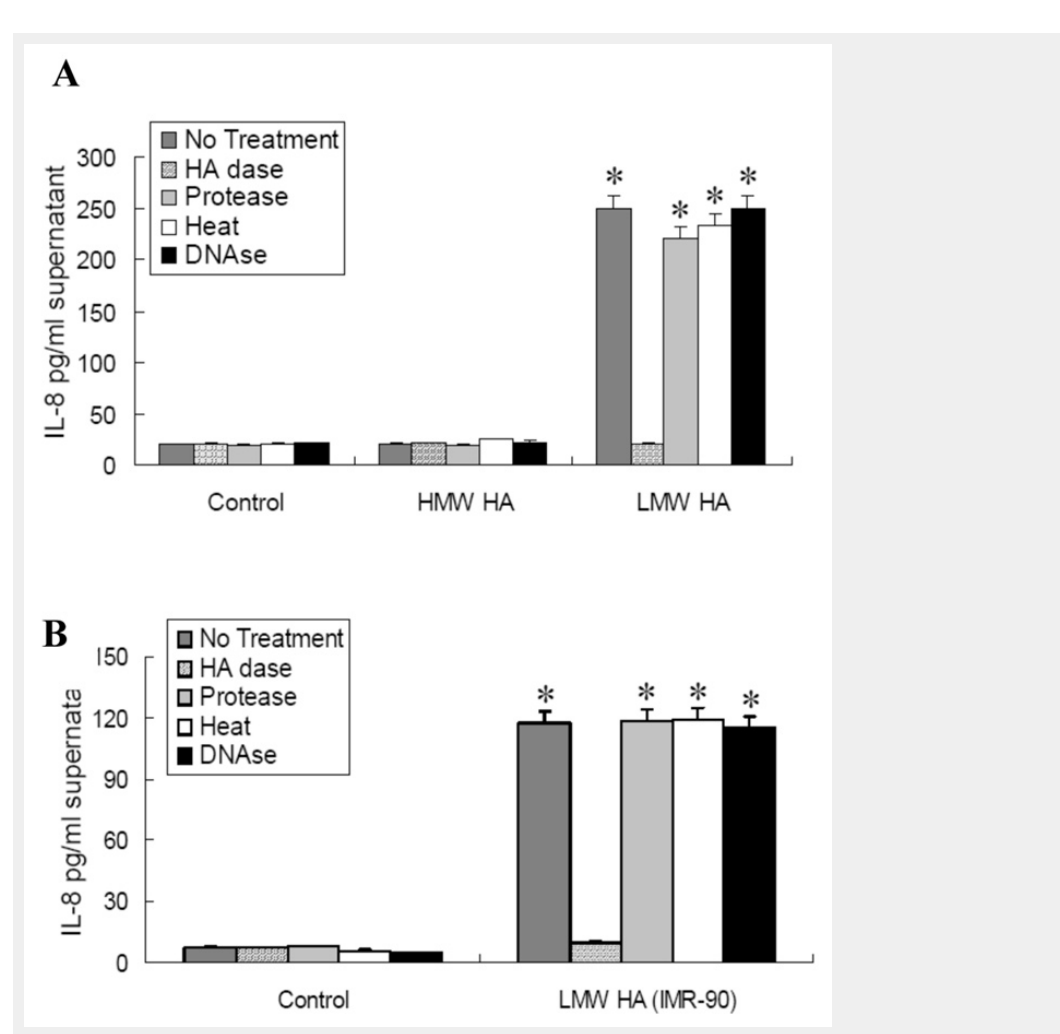
Figure 1 IL-8 production was stimulated by LMW-HA but not by HMW HA in human transformed bronchial epithelial cells (BEAS-2B cells) BEAS-2B cells were incubated with LMW-HA, HMW HA, or no HA in serum-free media for 6 hours. A. Effect of LMW-HA from bovine vitreous humor and HMW HA from rooster comb on IL-8 production (n = 5); B. Effect of LMW-HA isolated from IMR-90 fibroblasts (n = 3) on IL-8 production. HAdase treatment completely blocked LMW-HA-induced IL-8 production. Protease treatment, heat treatment and DNAse pre-treatment had no effect on LMW-HA-induced IL-8 production. * p <0.05 vs HMW HA exposure and no HA